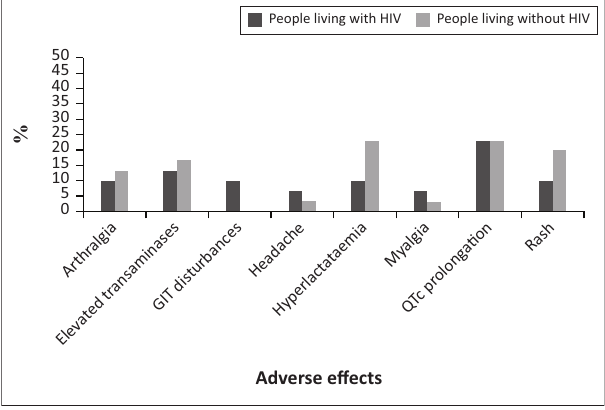
FIGURE 2: Adverse effects experienced by patients living with and without human immunodeficiency virus being treated with bedaquiline ( N =